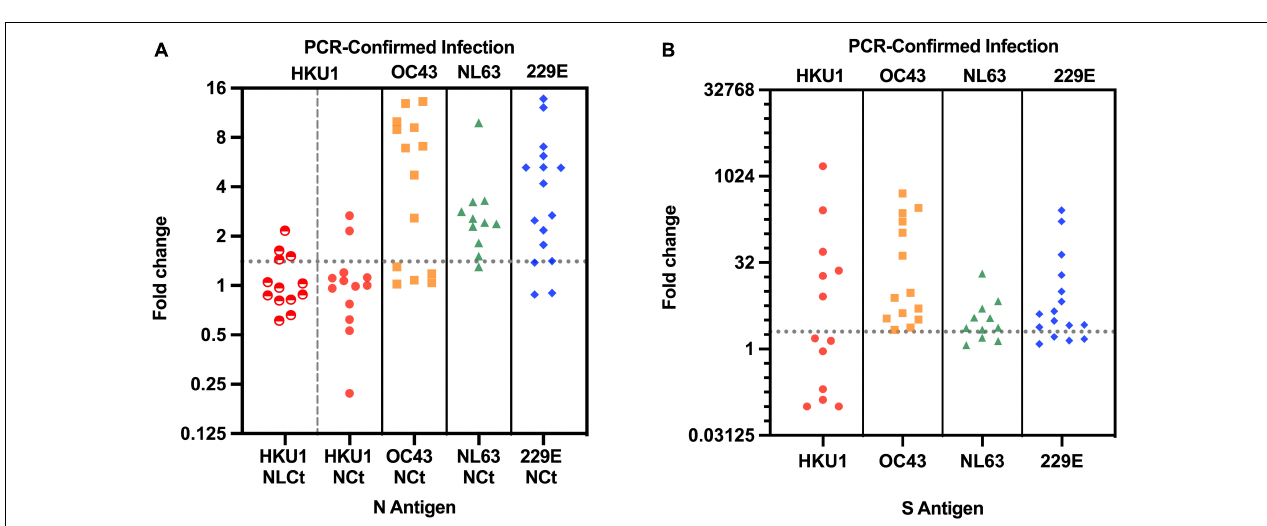
FIGURE 1 | (A) Location of Nt-, Ct-, and linker (L)-domain of HCoV-HKU1 N as determined by pairwise alignment with HCoV-OC43, as well as the comparison of size between HKU1-NLCt and the HKU1-NCt antigen. (B) Multiple alignment of the nucleocapsid L domain of HCoV-NL63, HCoV-229E, HCoV-OC43, and HCoV-HKU1. The symbols below the aligned amino acid sequence represent the consensus symbol of amino acid residue at each position: asterisks (*) denotes fully conserved residue, colons (:) denotes amino acid residues with strongly similar property, periods (.) denotes amino acid residues with weakly similar property, and the absence of symbol denotes completely different property.